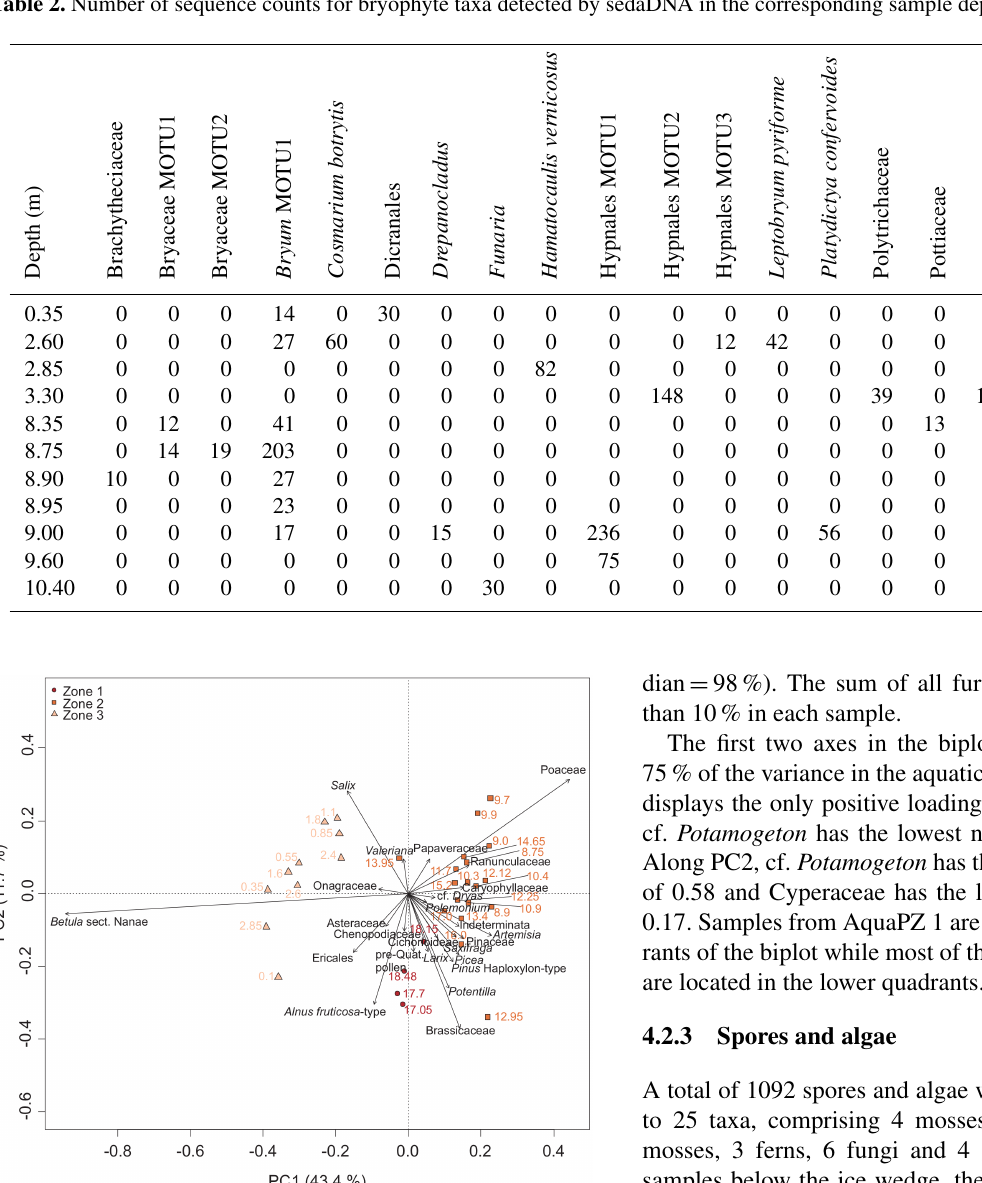
Table 2. Number of sequence counts for bryophyte taxa detected by sedaDNA in the corresponding sample depths.